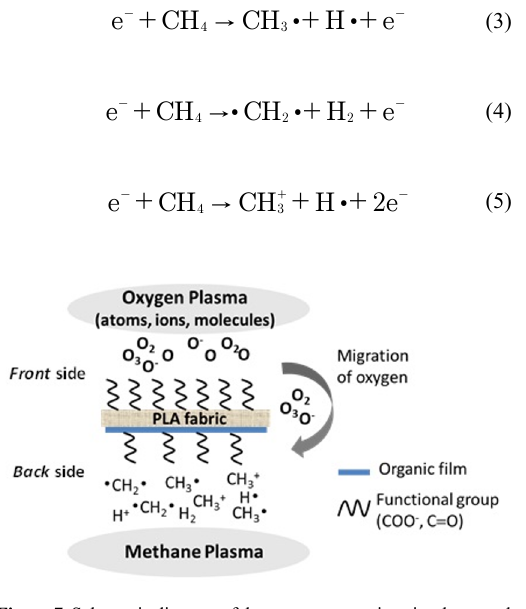
Figure 7. Schematic diagram of the process occurring simultaneously with the PLA fabric, during the plasma